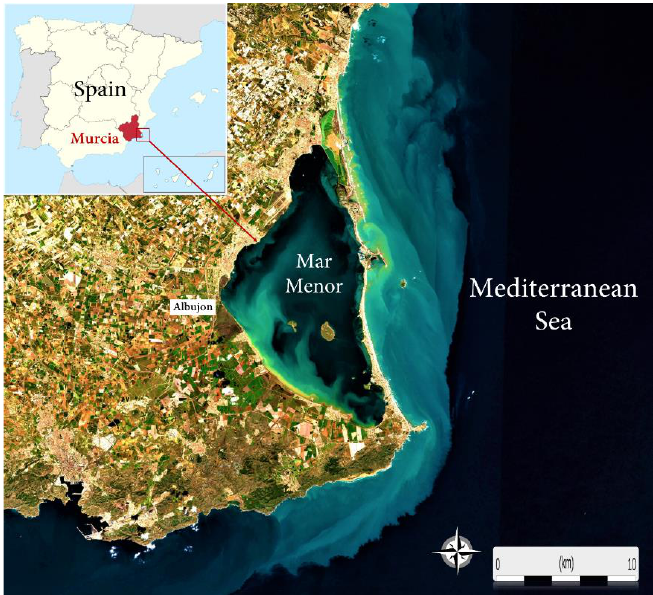
Figure 1. Location of the Mar Menor coastal lagoon on the southeastern coast of Spain and Sentinel-2 image captured on 21 March 2021 indicating the final transect of the Albujon watercourse flowing into the lagoon.